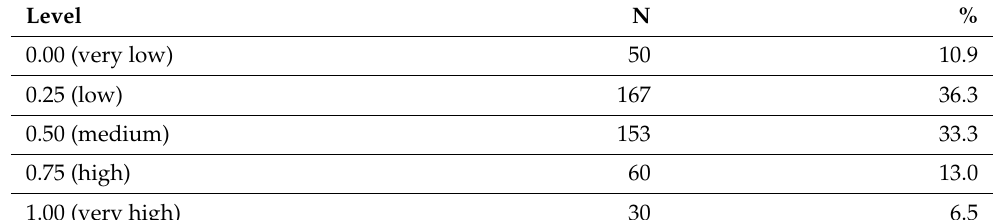
Table 5. Distribution of the sample in the levels of the independent variable “Exposure to pornography”.